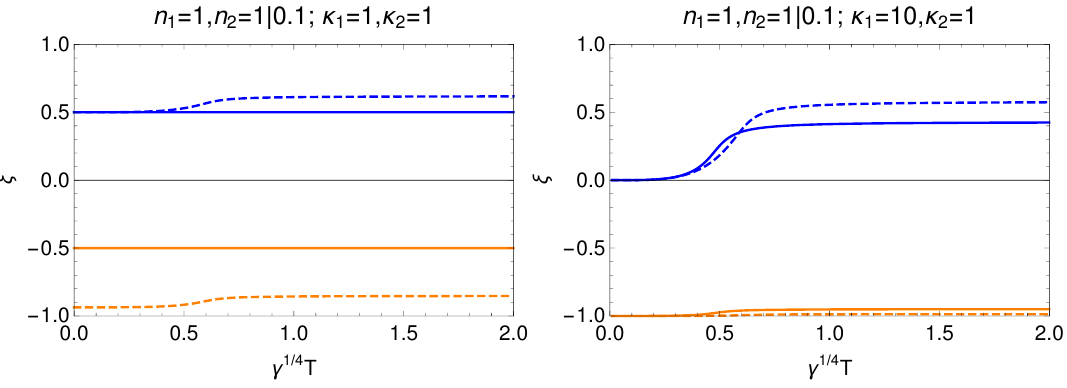
Figure 9 . The relation between the velocity amplitudes (cid:23) and ~ (cid:23) of the shear eigenmodes displayed in (cid:12)gure 8 in the form (cid:24) (cid:17) 2 arctan(~ (cid:23)=(cid:23) ). A value of (cid:24) = 0 or (cid:24) = (cid:6) 1 (with these two latter values (cid:25) to be identi(cid:12)ed) means that the mode is carried only by subsystem 1 or 2, respectively; (cid:24) = 0 : 5 or (cid:24) = (cid:0) 0 : 5 corresponds to exactly equal amplitudes with equal or opposite